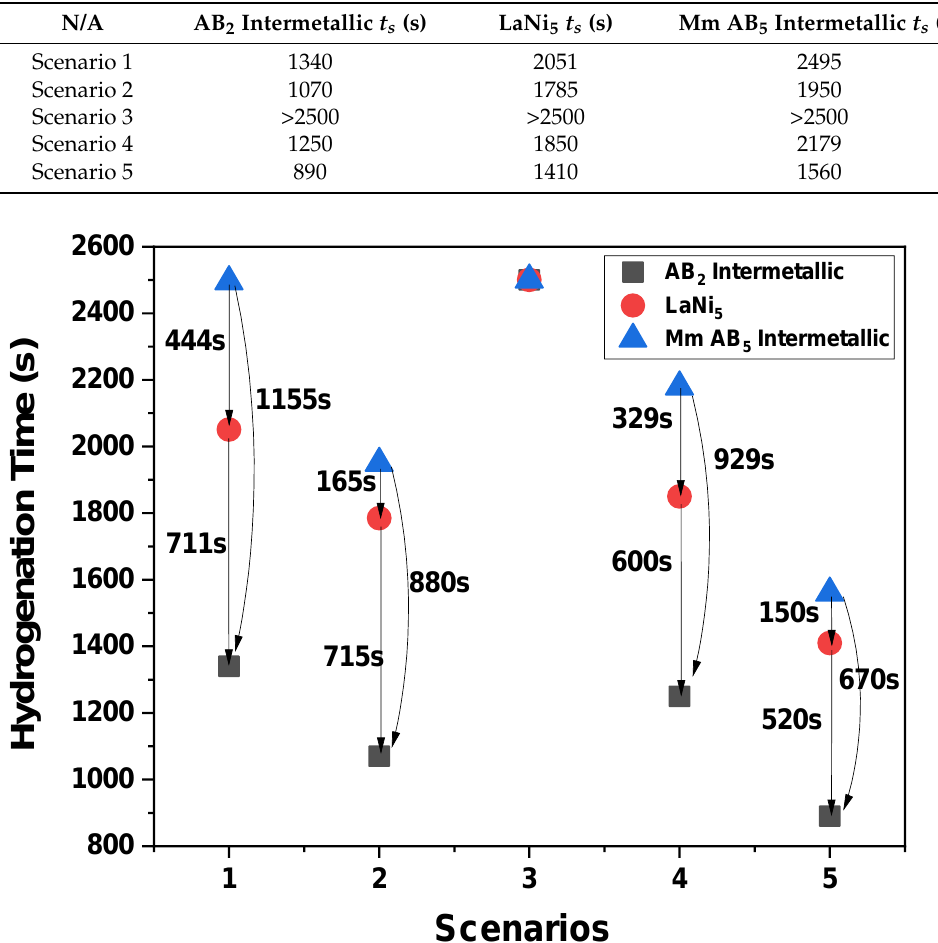
Figure 4. Comparison of the hydrogenation time for all scenarios and all materials studied.